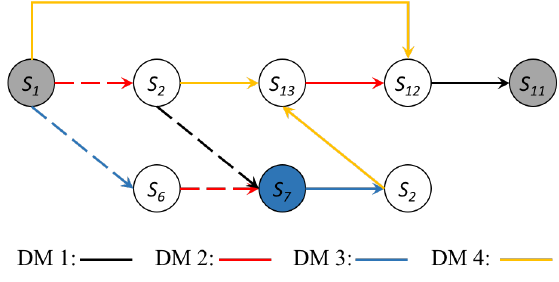
Figure 14. Actual evolution